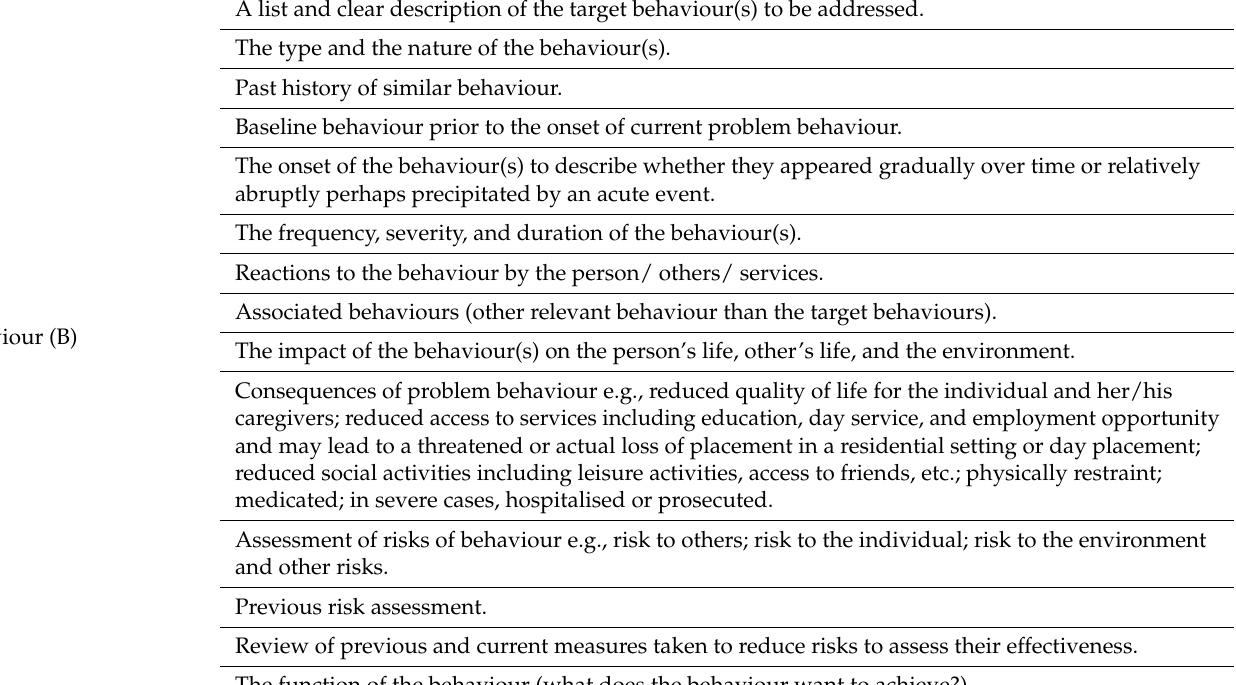
Table A1. BMPPS model of challenging